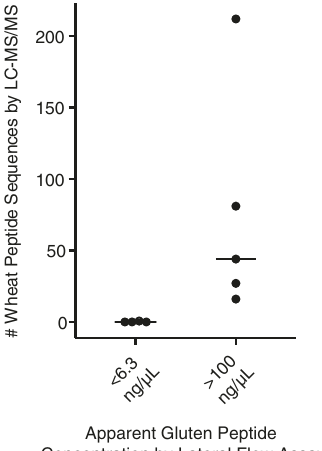
Fig. 4 LC – MS/MS analysis of banked urine samples from patients with CeD 27 . Urine collected from a single void was tested for the presence of gluten by an A1 and G12 monoclonal antibody-based lateral fl ow assay. Each data point represents a single urine sample, and the horizontal bar indicates the median. Information associated with the identi fi cation of these peptide sequences by LC – MS/MS is provided in Supplementary Dataset 6. Source data are provided as a Source Data fi